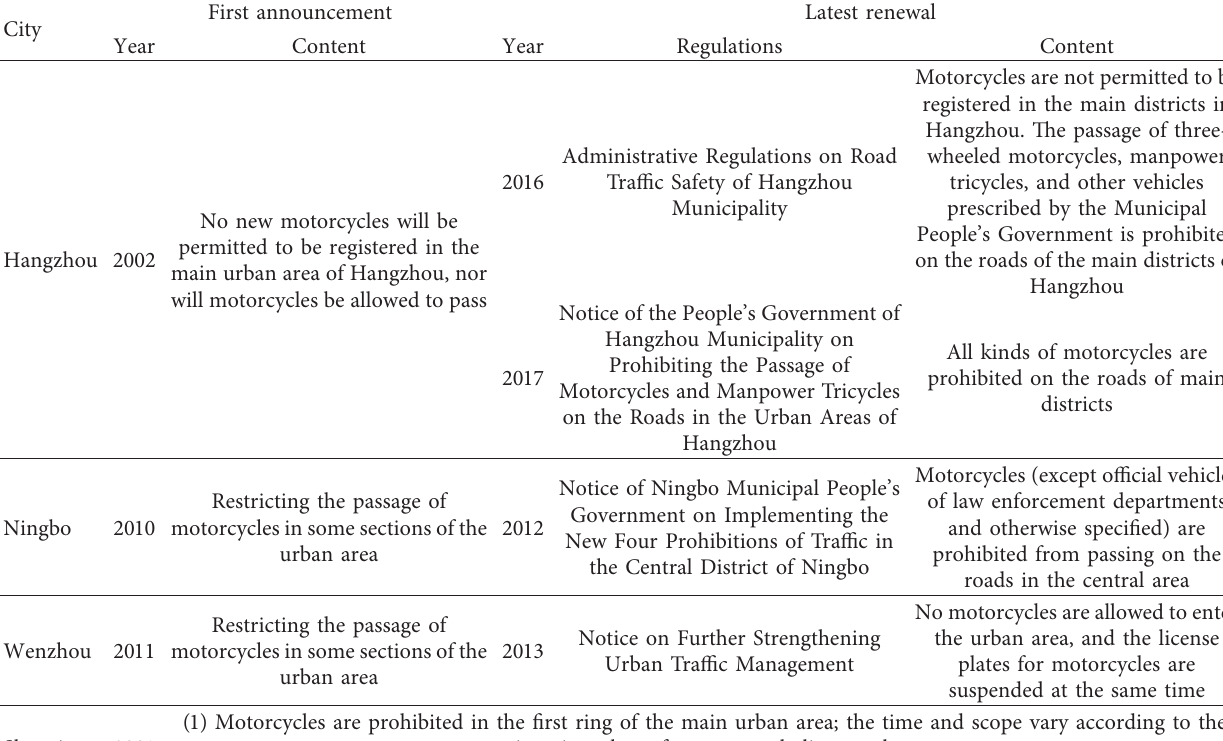
Table 2: Regulations of motorcycles on urban roads in prefectural cities in Zhejiang Province.